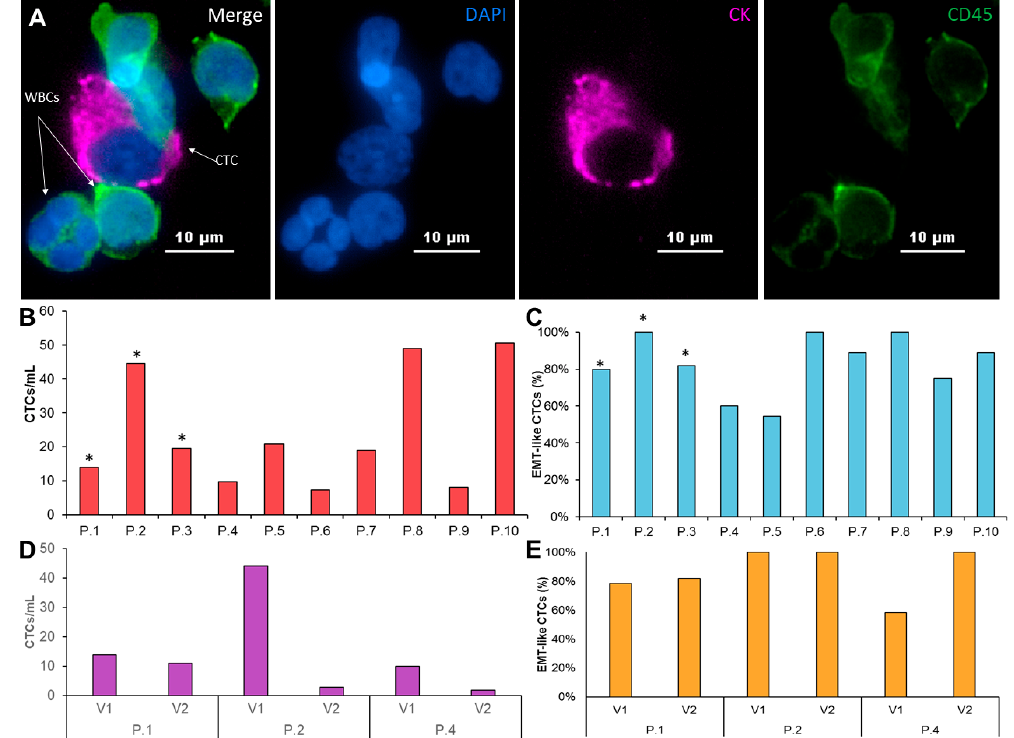
Figure 2. Characterization of patient-derived pancreatic CTCs. ( A ) A patient derived CTC (shown in pink), along with WBCs (shown in green) stained with CK 19, CD45, and DAPI. ( B ) CTC/mL enumeration for 10 PDAC patients. Asterisk marks the samples that were successfully expanded. ( C ) Coexpression percentage of cytokeratin and vimentin of CTCs isolated from 10 PDAC patients. ( D ) CTC/mL enumeration from two consecutive visits of 3 patients prior to treatment and after first round of chemotherapy. (E) two consecutive visits of 3 patients prior to treatment and after the first course of chemotherapy.